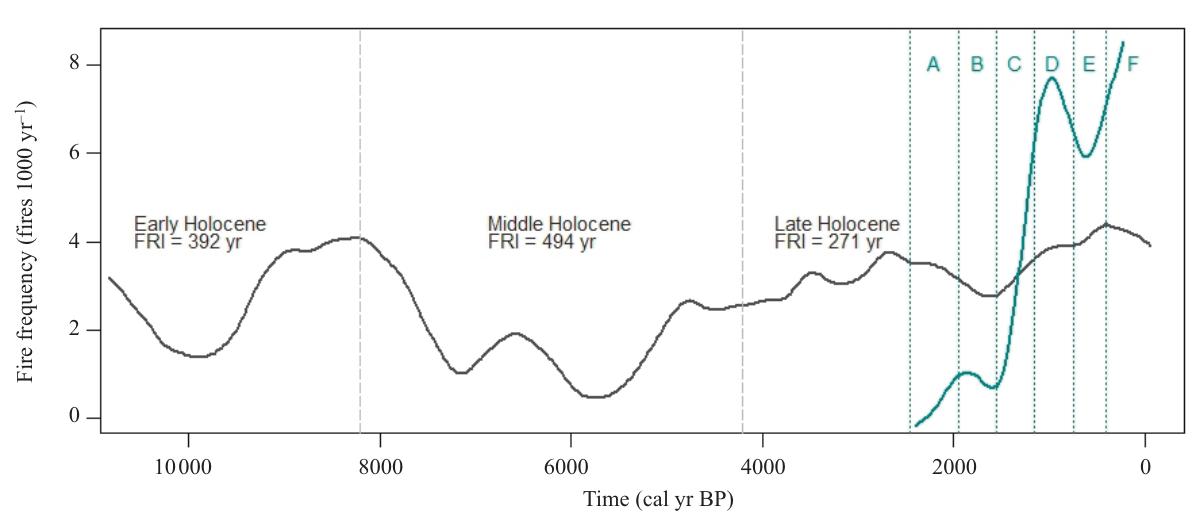
Fig. 4. Reconstructed fire frequency (fires per 1000 yr –1 ) for Lake Bricu I (black solid line) and II (green solid line), raw results from CharAnalysis. A – Earliest Iron Age, B – Early Iron Age, C – Middle Iron Age, D – Late Iron Age, E – Medieval period, F – Modern times (archaeological periodization according to Vasks et al. (1999) and Graudonis (2001)).